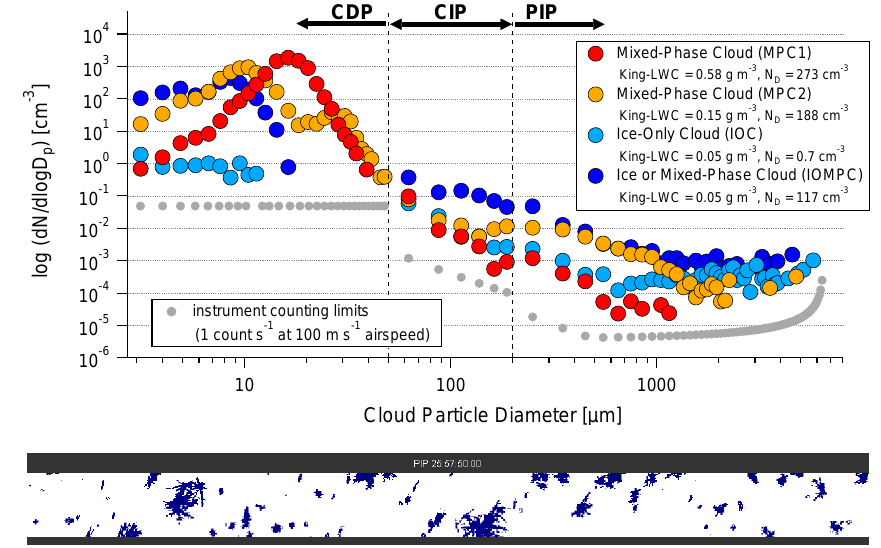
Fig. 8. Example cloud particle size distributions (derived from CDP, CIP and PIP measurements) for two Mixed-Phase Clouds (MPC), an Ice-Only Cloud (IOC) and an Ice or Mixed Phase Clouds (IOMPC) on the 19 April 2008 ARCPAC flight. Criteria for phase determination and definition of a cloud are presented in Sect. 3.3. Also shown are images from the PIP for the